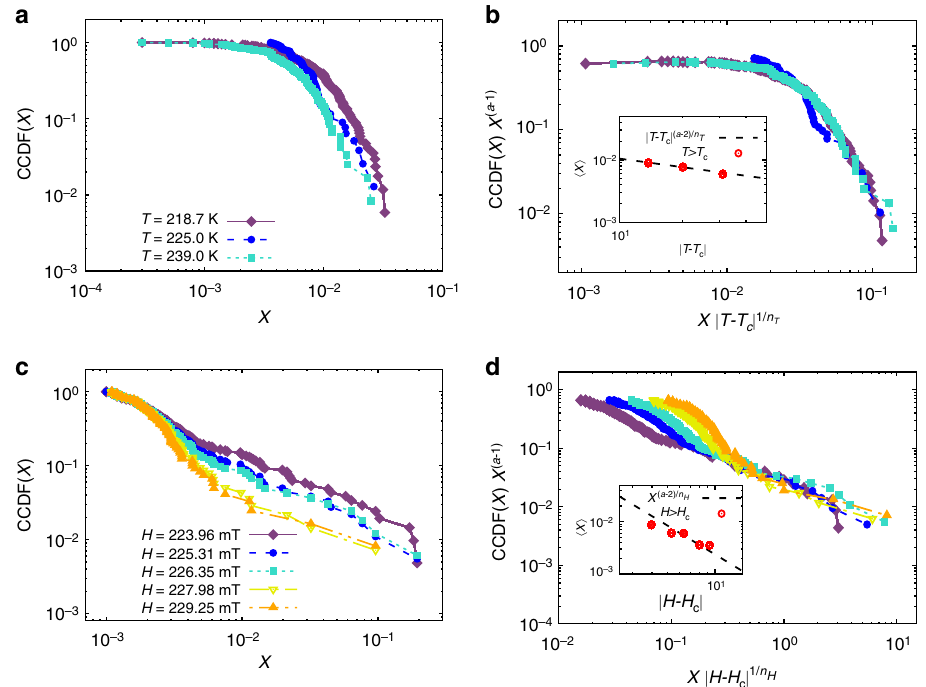
Fig. 6 Scaling collapse for skyrmion phase: Complementary cumulative distribution function of domain cascades in the skyrmion phase, with critical values T = 205.6 K and H = 220mT. ( a ) Data at H = H T = T H = H T = T Cs k Csk Csk and ( c ) Data at Csk . Scaling collapse at Csk ( b ) and Csk ( d ). Inset: The average size of the jumps as a function of the distance to the critical point. The dashed line represents the fi t to 〈 X 〉 ( μ ) ∼ | μ − μ C | ( a − 2)/ n , with μ = T or μ = H . The values of the critical exponents for fi eld and temperature are a H sk = 1.1 ± 0.2, n H sk = 0.5 ± 0.2 and a T sk = 1.1 ± 0.3, n T sk = 2.06 ± 0.5,